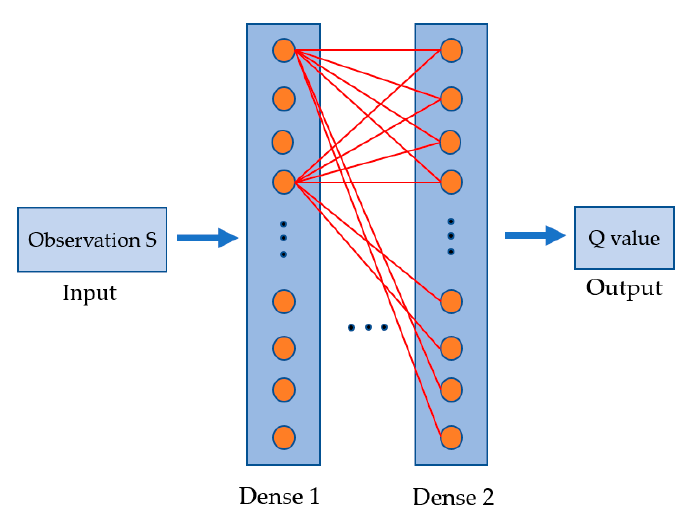
Figure 3. Neural network based value function approximator of Reinforcement learning.